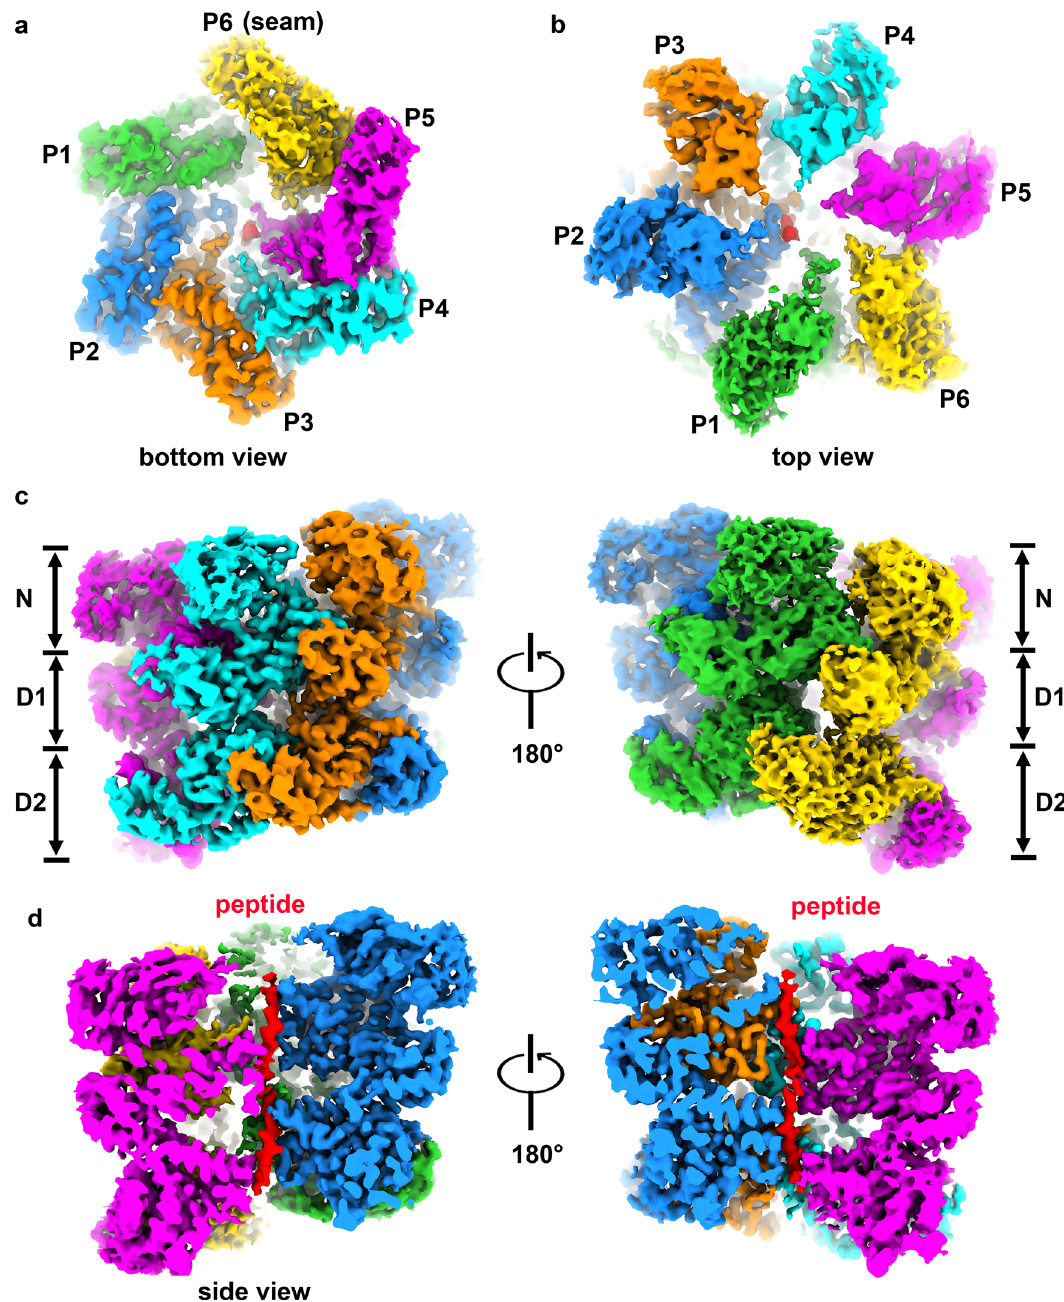
Fig. 2 | Cryo-EM structure of the double mutant Drg1 E346Q/E617Q hexamer in the presenceofATP.a , b Cryo-EMmapofthedoublemutantDrg1 E346Q/E617Q hexamerin the presenceof ATP, viewedfrom the D2 ( a ) and NTD( b ) directions. c